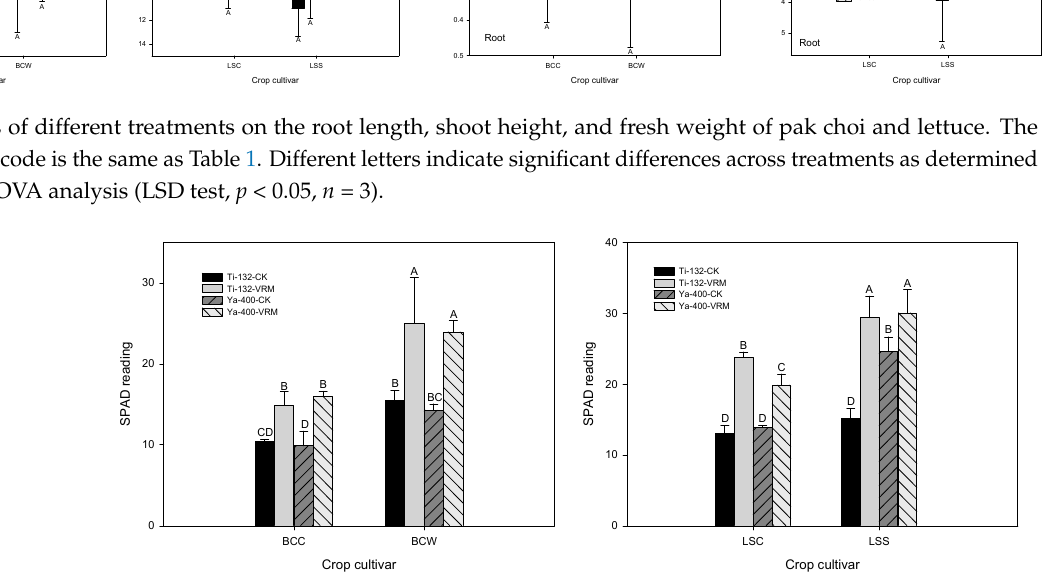
Figure 2. Effects of different treatments on the SPAD readings for pak choi and lettuce. The meaning of each code is the same as Table 1. Different letters indicate significant differences across treatments as determined by one-way ANOVA analysis (LSD test, p < 0.05, n = 3).